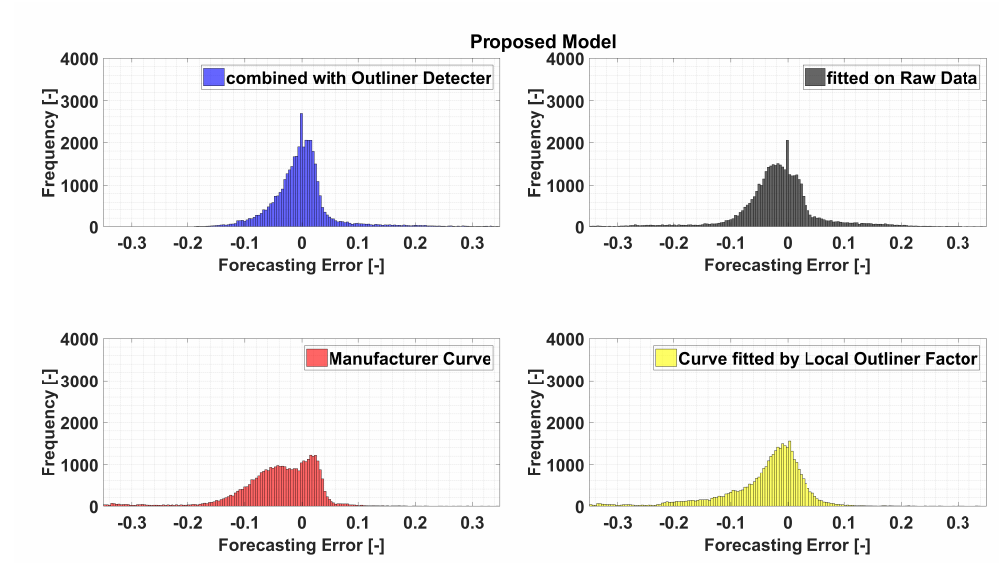
Figure 10. Frequency distribution of the forecasted power error. Table 4. Synthesis results on the corresponding obtained improvements.